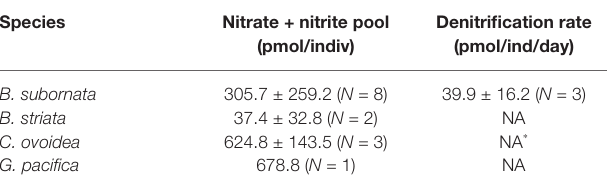
NA, species not examined for their denitrification capacities. NA * , one specimen of C. ovoidea was measured and no denitrification was detected, however, replicate measurements would be required to verify the result.